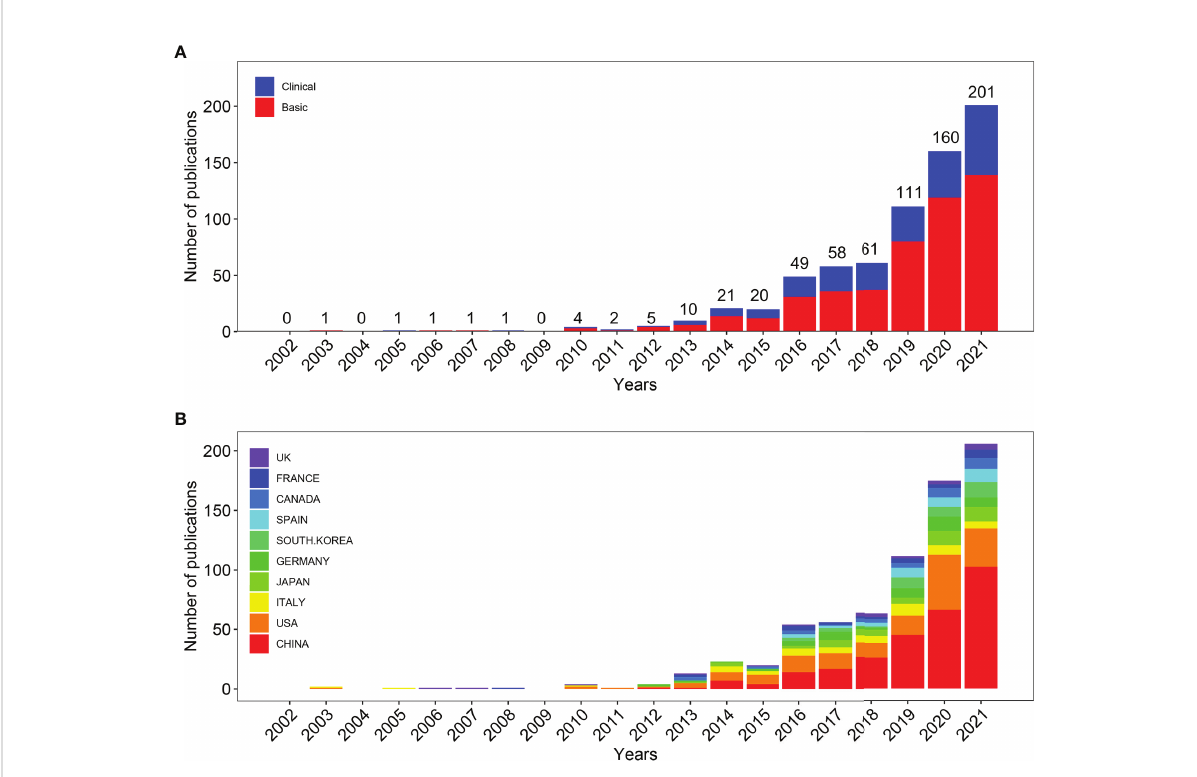
FIGURE 2 Quantity and Trends Analysis of Published Papers on the links between the gut microbiota and MAFLD between 2002 and 2021. (A) The number of annual research publications and research types on the links of gut microbiota and MAFLD from 2002 to 2021, export of results from Web of Sciences. (B) The number of annual research publications and growth trends on the links of gut microbiota and MAFLD from 2002 to 2022, export of results from the Online Analysis Platform of Literature